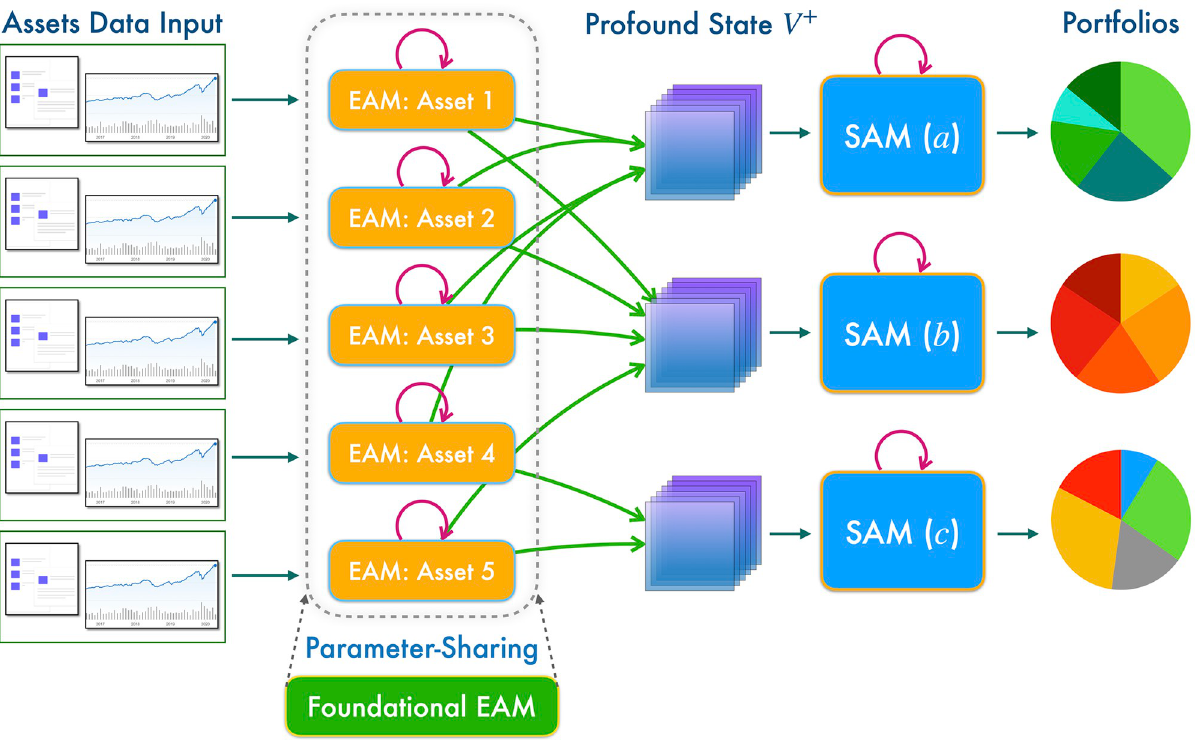
Fig 1. Overview of the surjection relationship between Evolving Agent Modules (EAMs) and Strategic Agent Modules (SAMs). Each EAM is responsible for a single asset and employs a DQN agent, and it utilizes heterogeneous data to produce signal-comprised information. Each SAM is a module for a portfolio that employs a PPO agent to reallocate the assets with stacked signal-comprised 3-D tensor profound state V + from EAMs connected. Moreover, trained EAMs are reusable for different portfolios and therefore can be combined and connected to any SAMs at will. By parallel computing, capital reallocation may be performed for various portfolios at scale